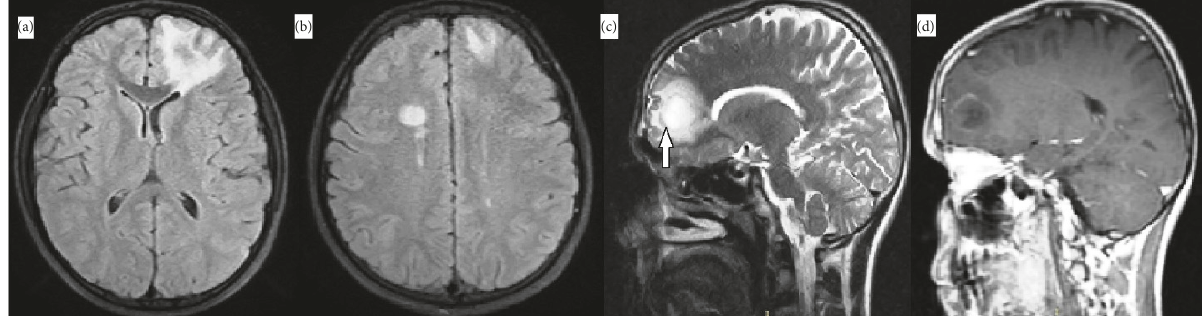
Figure 1: Initial imaging findings. (a) Axial fluid attenuation inversion recovery (FLAIR) image reveals a large hyperintense lesion in the left frontal lobe with surrounding vasogenic edema. (b) Axial FLAIR image shows hyperintense demyelinating lesions in bilateral subcortical white matter. (c) Sagittal T2-weighted image demonstrates T2 hypointense rim (arrow). (d) Sagittal T1-weighted postcontrast image shows ring enhancement.